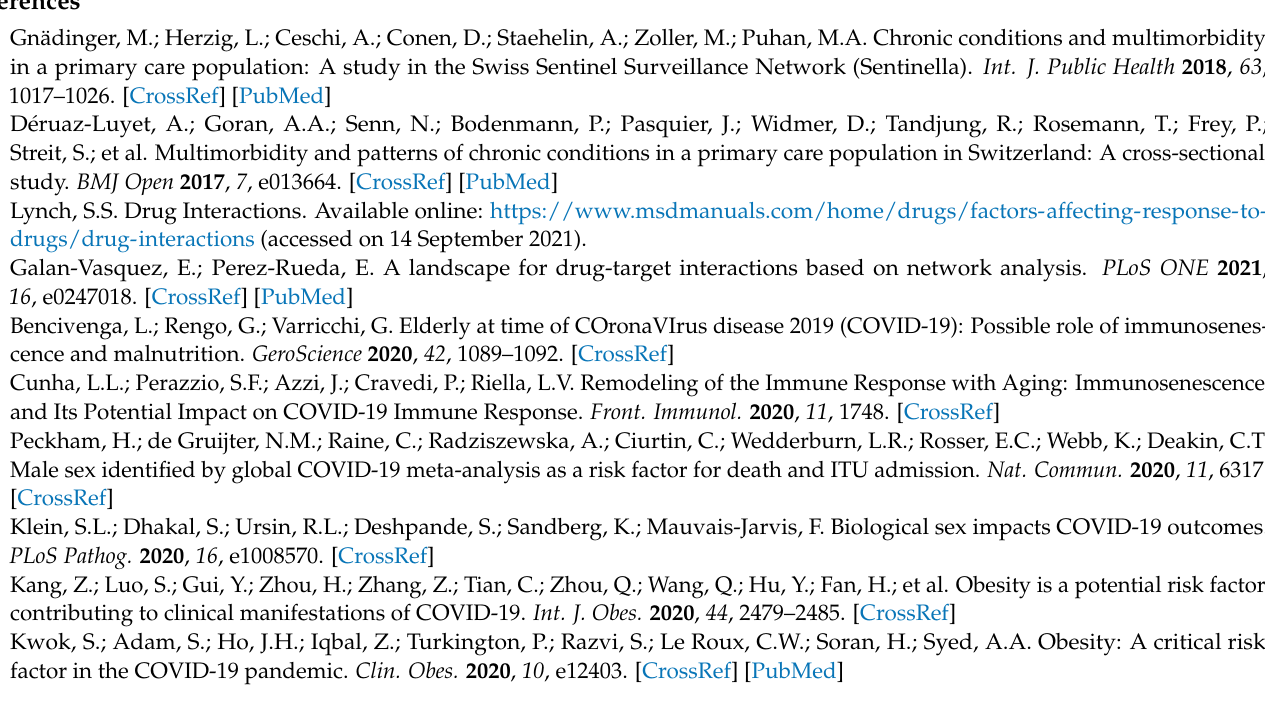
Table S3: Significant nodes of the DDSI network, disease specific; Table S4: Significant edges of the DDSI network, disease specific; Figure S1: Main target nodes; Figure S2: Target nodes with significant differences; Figure S3: Main target edges; Figure S4: Target edges with highly significant differences ( p <